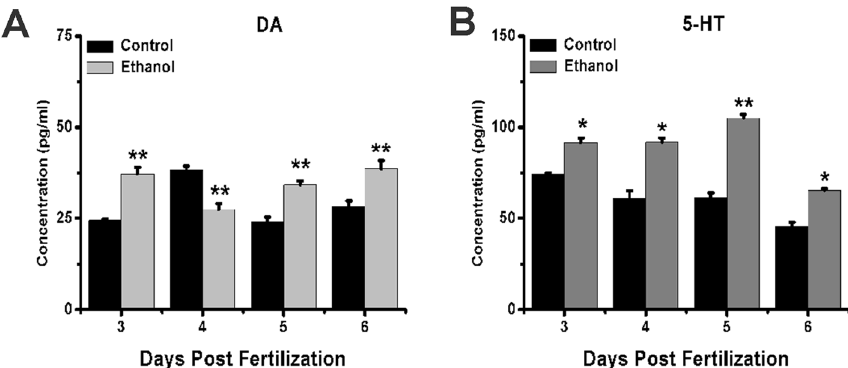
Figure 4. Level of neurotransmitters in zebrafish larvae after ethanol exposure. Samples were taken at 3, 4, 5, and 6 dpf. (A) Dopamine concentration from 3 to 6 dpf. (B) 5-HT concentration from 3 to 6 dpf. Three